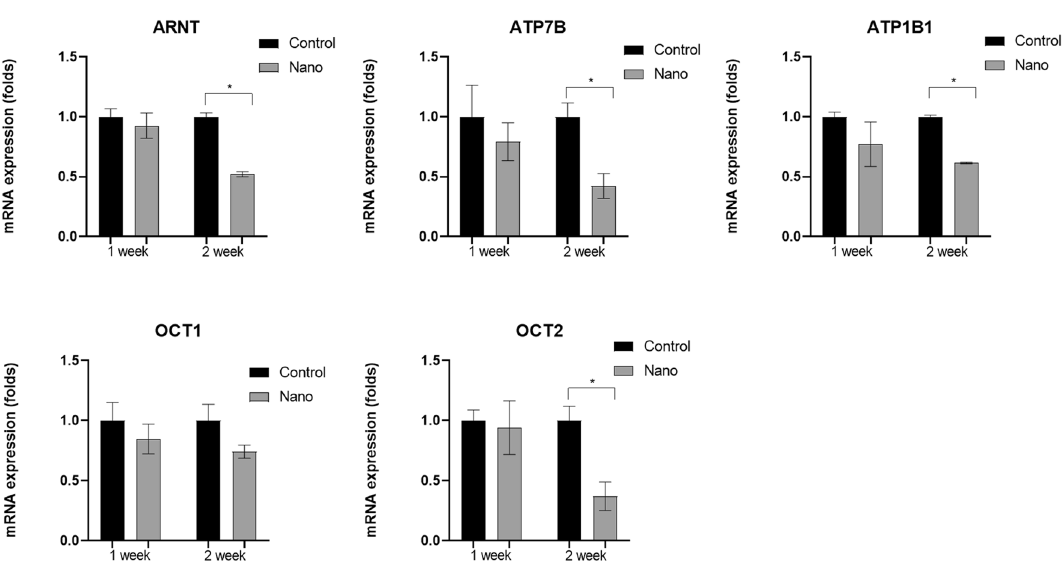
Figure 7. Comparisons of the mRNA expression levels of five genes encoding cation transporters ( ARNT, ATP7B, ATP1B1, OCT1, and OCT2 ) in the olfactory bulb between the control and nano groups. ARNT, ATP7B, ATP1B1, and OCT2 expression levels were increased in the olfactory bulb in the nano group compared with the control group (n = 9 per group). *, P < 0.05, unpaired t-test, control vs. nano